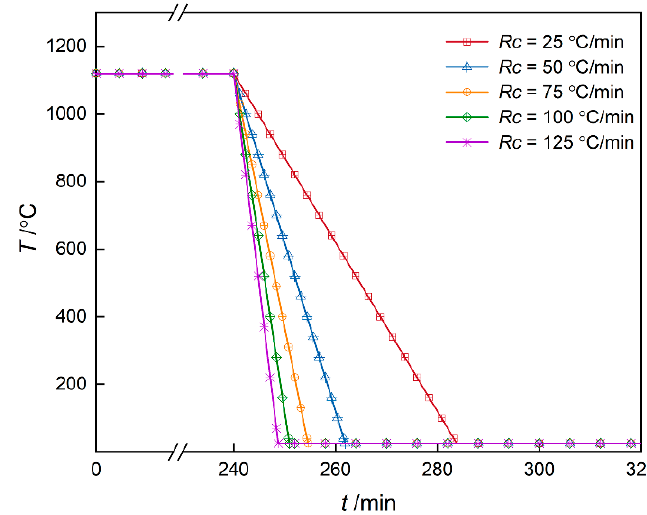
Figure 7. The cooling curve of DD6 superalloy sketch diagram.